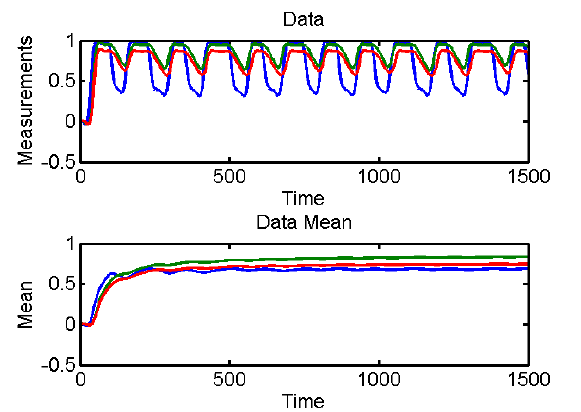
Figure 2: Measurements and mean of chlorine data (blue: Figure 2. Measurements and mean of chlorine data sensor 1, red: sensor 2, green: sensor (Blue: sensor 1, red: sensor 2 and green: sensor 3)